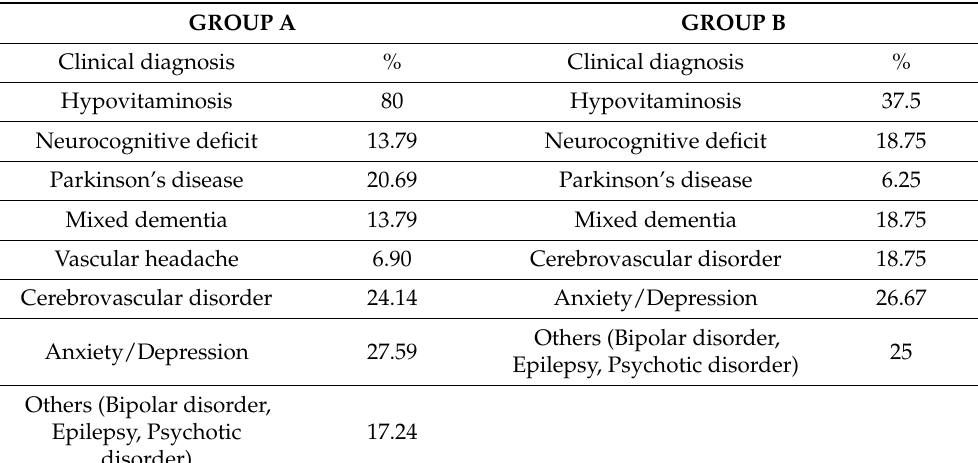
Table 1. Clinical diagnosis. Distribution of patient diagnostics indicating the percentage of patients with (A) increased 5mC levels (Group A) and (B) unchanged levels of 5mC (Group B) in serum during the clinical